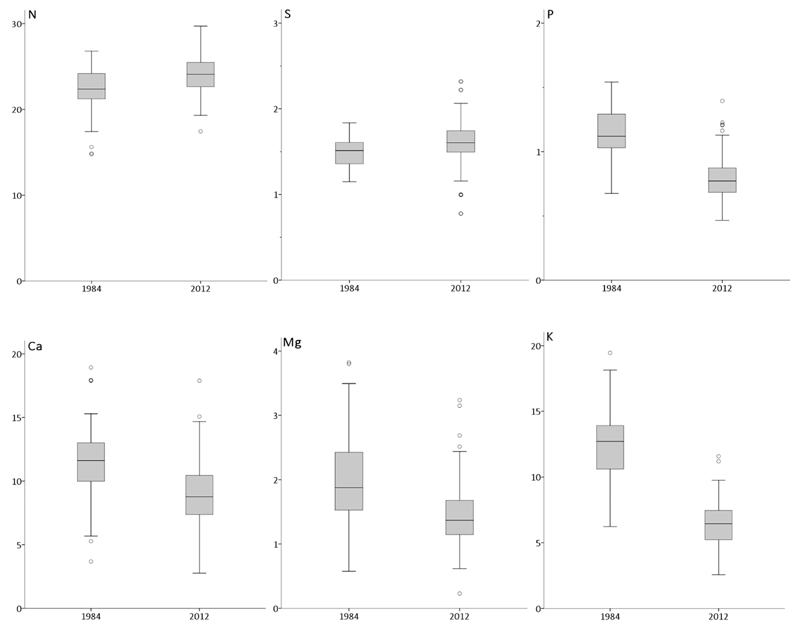
Box-and-whisker-plots illustrating total foliar contents of N, S, P, Ca, Mg and K (mg g−1) at 97 beech stands in the Vienna Woods. An individual plot may show 25%–75% (box; interquartile range, IQR), median (vertical line), whiskers (error bars; <1.5 IQR from upper or lower quartile) and outliers (circles; 1.5–3.0 IQR from upper or lower quartile). Extreme cases (>3.0 IQR from upper or lower quartile) are not shown.